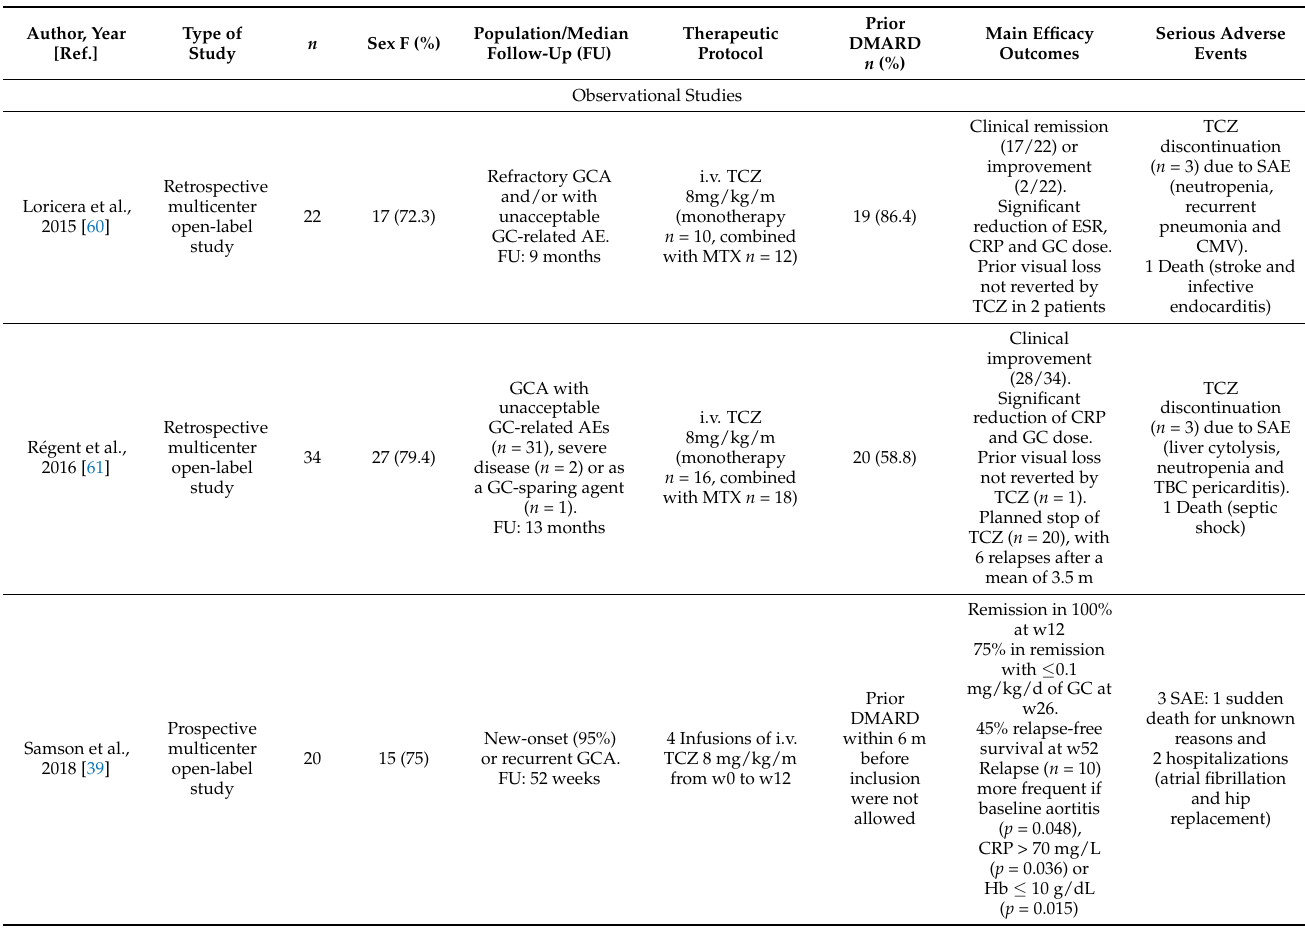
Table 1. Tocilizumab in giant cell arteritis. Main observational studies including 15 or more patients and randomized clinical